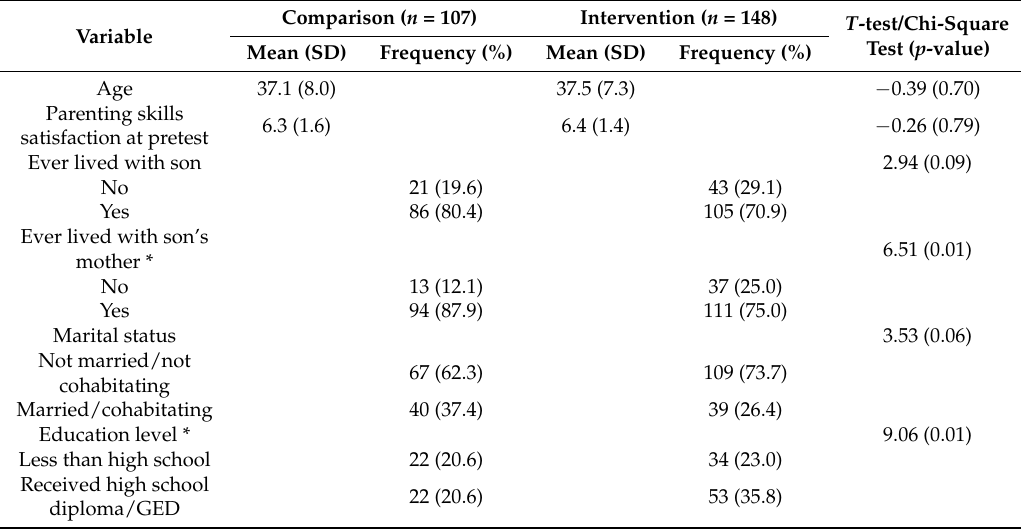
Table 1. Descriptive statistics of study variables in the comparison and intervention